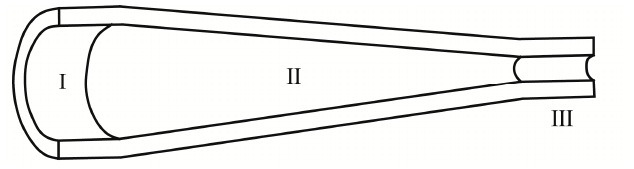
Figure 3. Cutaway view of the 3D model of the straight cone nozzle.